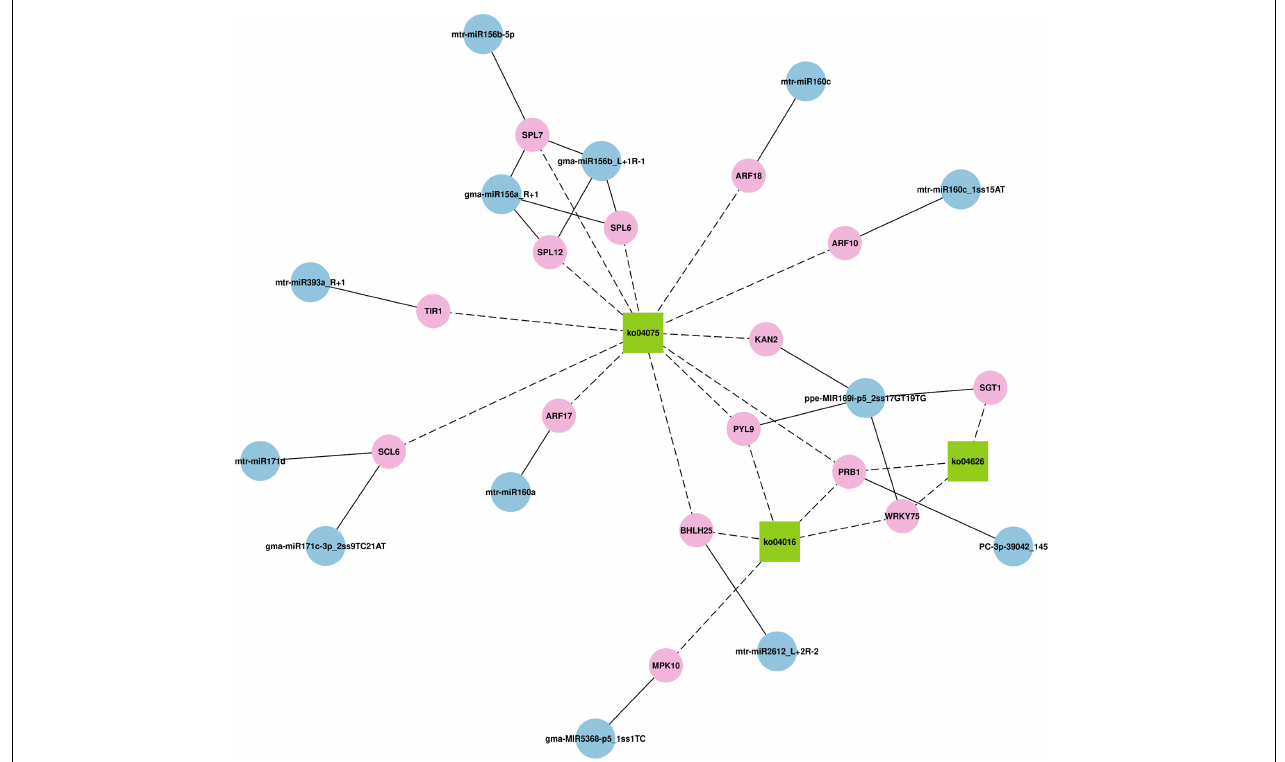
FIGURE 5 | The network plot for the miRNAs and their targets associated with ko04016 (MAPK signaling pathway – plant) pathways, ko04075 (plant hormone signal transduction), and ko04626 (plant–pathogen